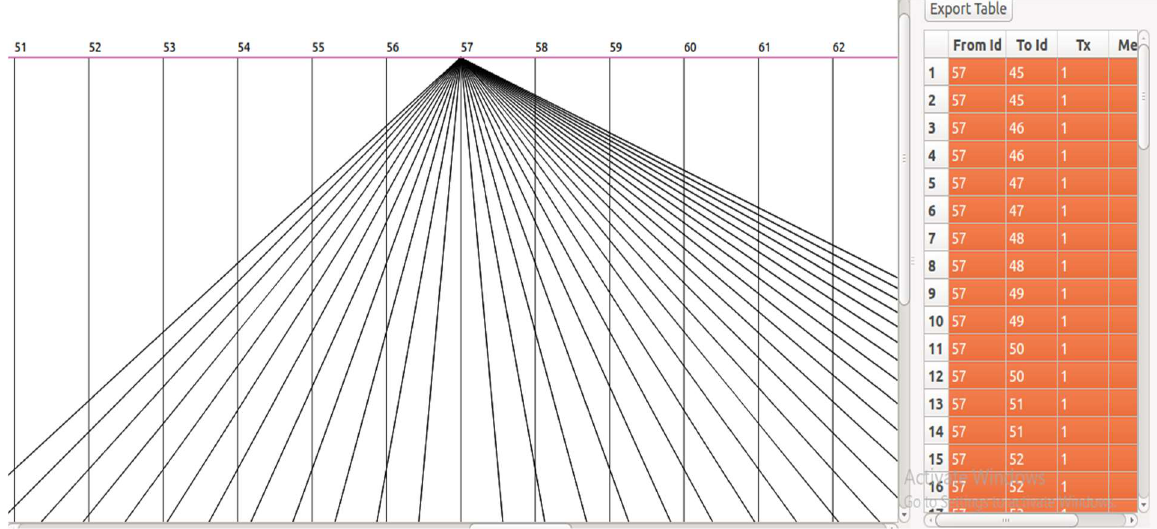
Figure 5. Optimal node placement relative to other nodes.